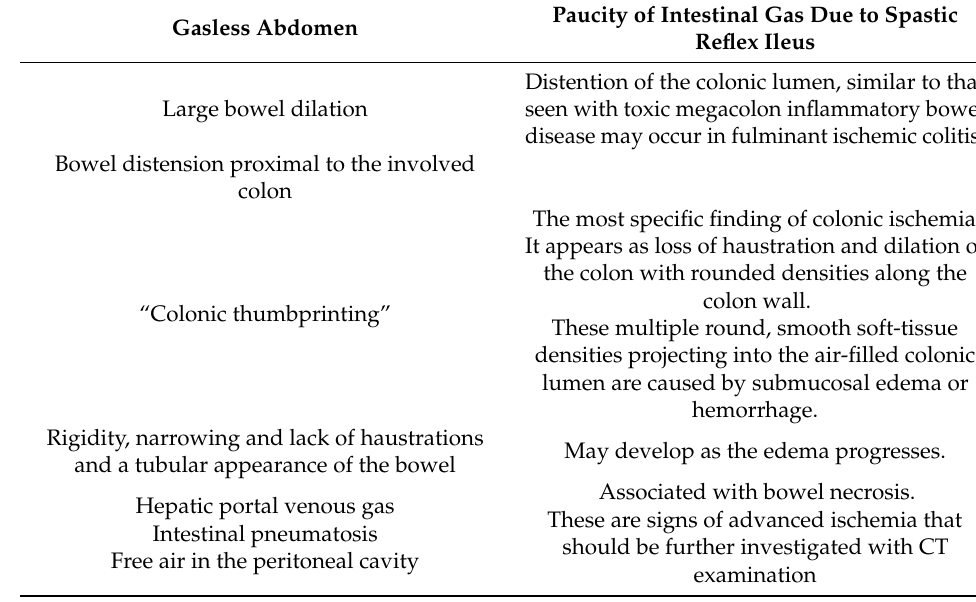
Paucity of Intestinal Gas Due to Spastic Reflex Ileus